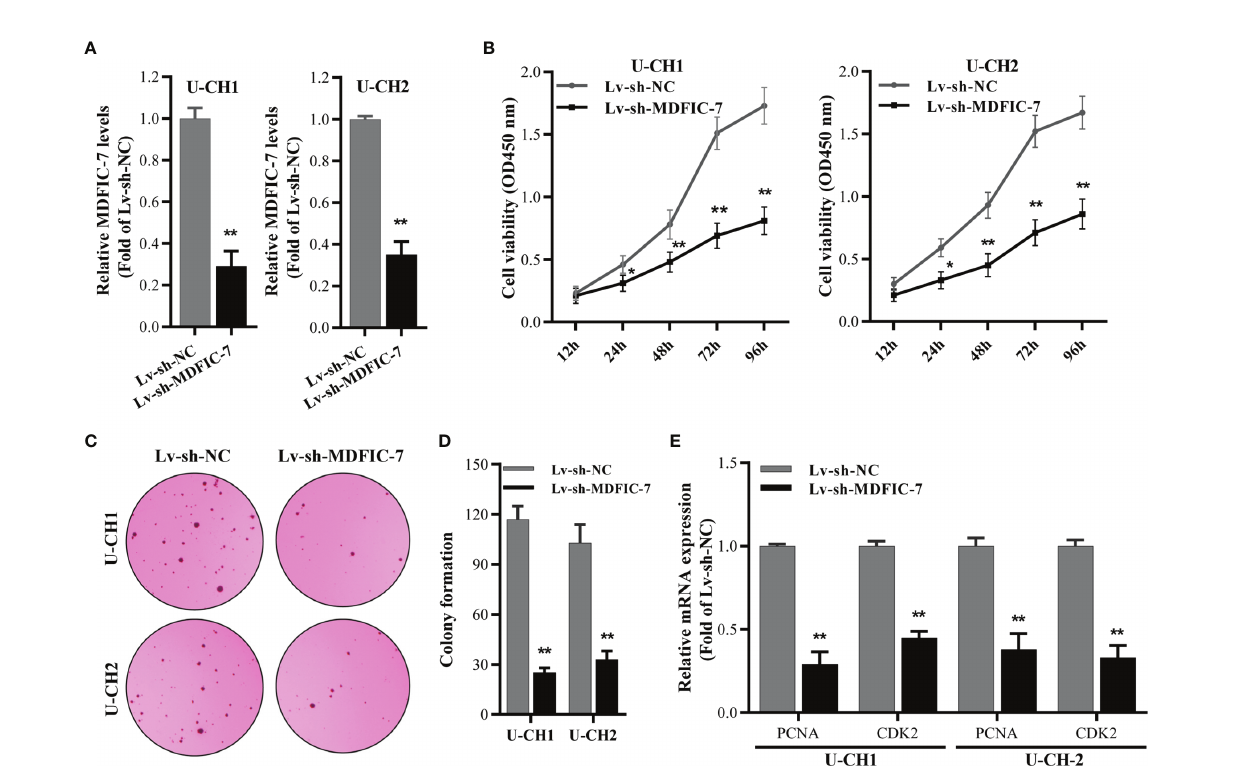
FIGURE 2 | LncRNA MDFIC-7 promotes chordoma cell proliferation. (A) qRT-PCR on U-CH1 and U-CH2 cells with lentivirus-induced knockdown of lncRNA MDIF-7 after 48 h. ** p < 0.01 vs . Lv-sh-NC. (B) CCK-8 assay in U-CH1 and U-CH2 cells after lentivirus infection at the indicated time points. * p < 0.05 vs . Lv-sh-NC, ** p < 0.01 vs . Lv-sh-NC. (C, D) Colony formation assay in U-CH1 and U-CH2 cells after infection with Lv-sh-NC and Lv-sh-MDFIC-7. ** p < 0.01 vs . Lv-sh-NC. (E) qRT-PCR analysis on mRNA expression of PCNA and CDK2 in U-CH1 and U-CH2 cells after knockdown of lncRNA MDFIC-7 by lentivirus infection. ** p < 0.01 vs .